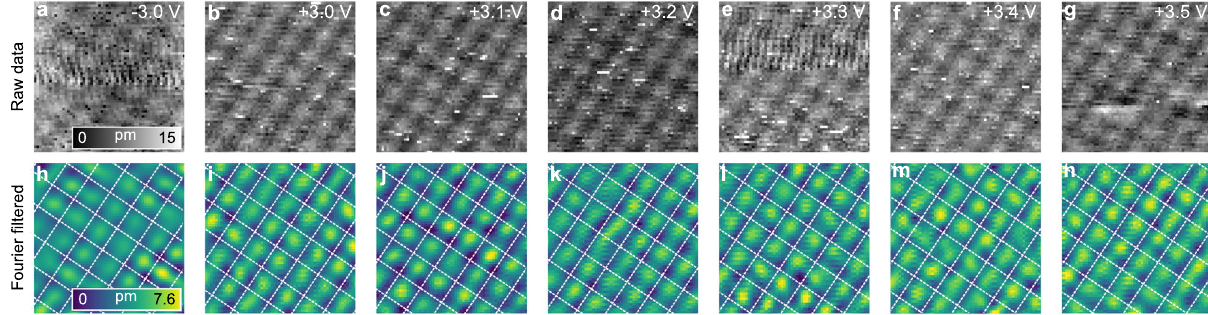
Fig. 2 STM of 3 ML NaCl(100) on Au(111) at voltages close to both edges of the band gap. a – g Raw (grayscale) and h – n Fourier fi ltered (coloured) at the indicated voltages, I T = 15 pA. Scale: 24 × 24 Å 2 . The white dashed lines mark the position of Na ion rows of the NaCl(100) lattice.